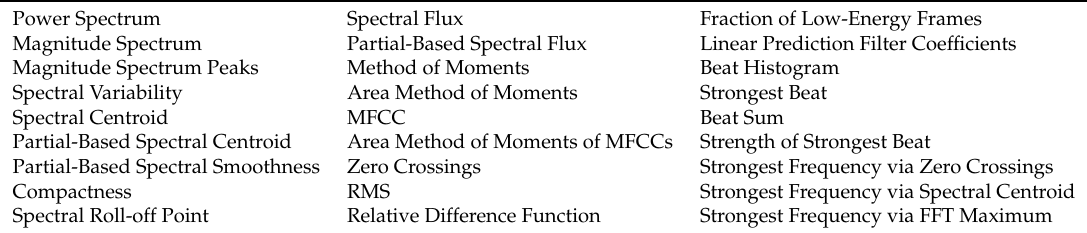
Table 3. List of feature types provided in jAudio [19]. FFT: fast Fourier transform; MFCC: mel-frequency cepstral coefficient; RMS: root mean square.